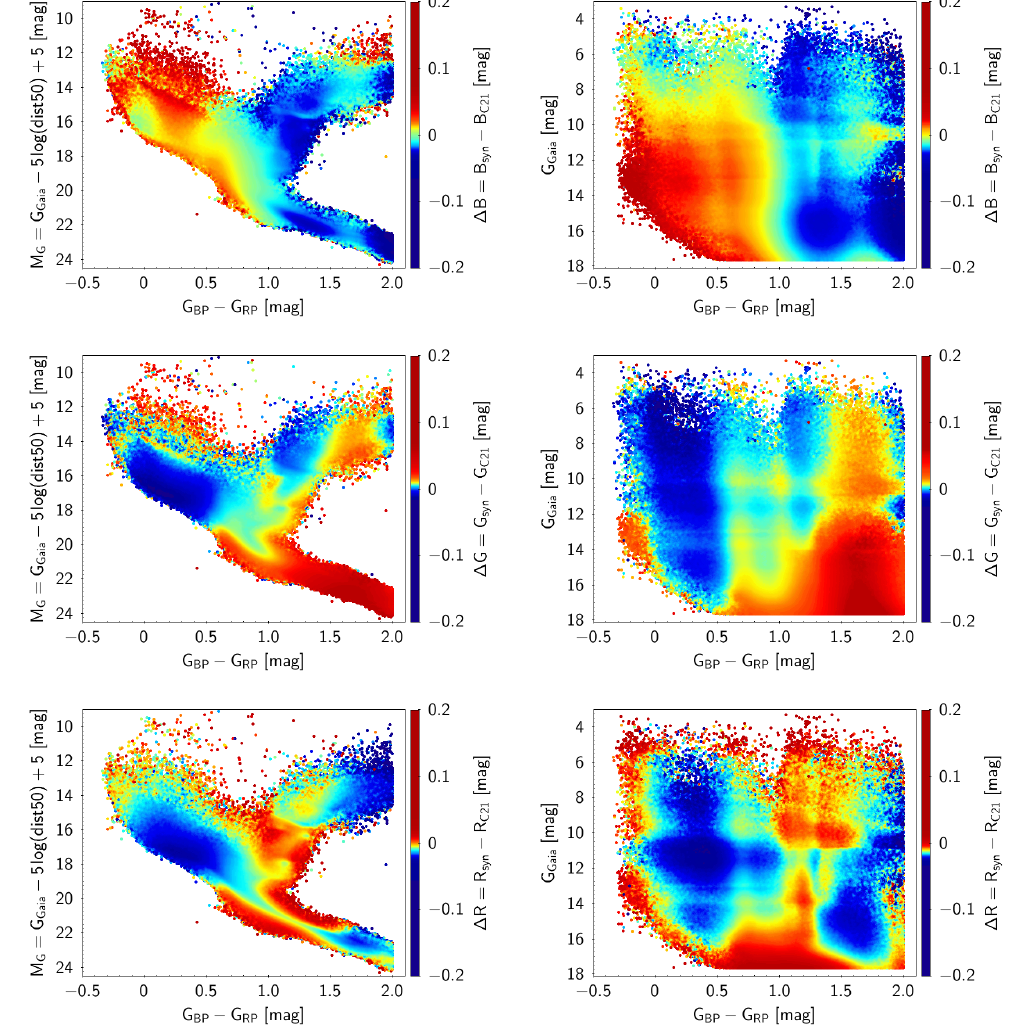
Figure 10. Absolute ( left column ) and apparent ( right column ) Gaia magnitude-colour diagrams for non-variable sources in common with C21. The colour index shows the difference between the synthetic magnitude ( X syn ) and those provided by C21 ( X C21 ) for X = B RGB ( top row ), G RGB ( middle row ) and R RGB ( bottom row